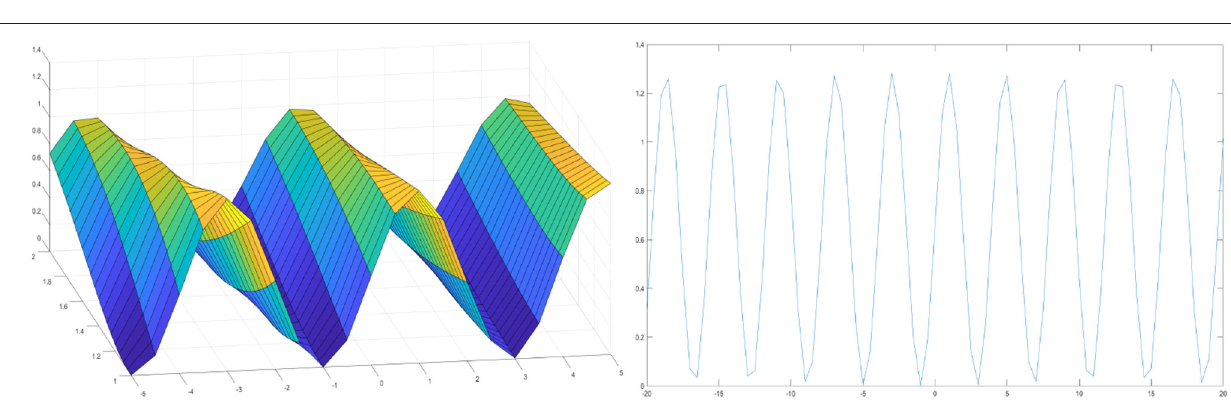
t . 1, α 3, p 1, β 2, γ ( t ) = = = − = = −